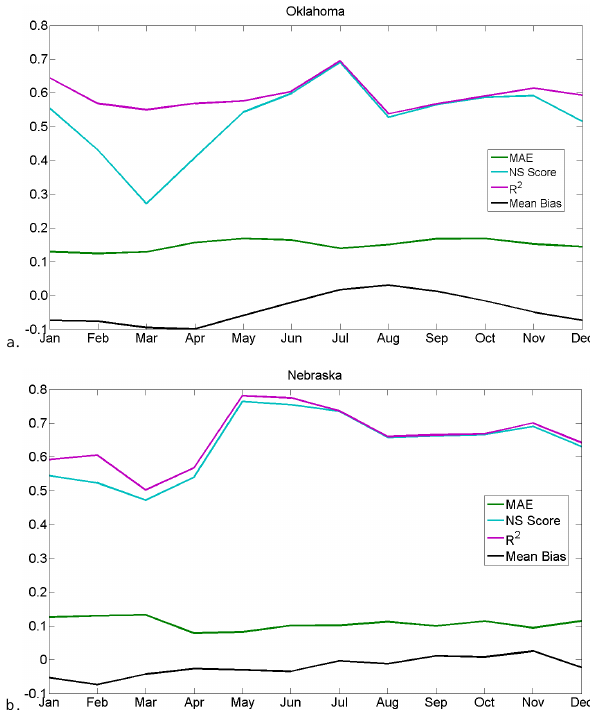
Figure 8 . Monthly average error metrics calculated from 5-25 cm soil moisture predictions. Fig. 8. Monthly average error metrics calculated from 5 to 25cm Results are averaged across all (a) Oklahoma and (b) Nebraska stations. soil moisture predictions. Results are averaged across all (a) Okla- homa and (b) Nebraska